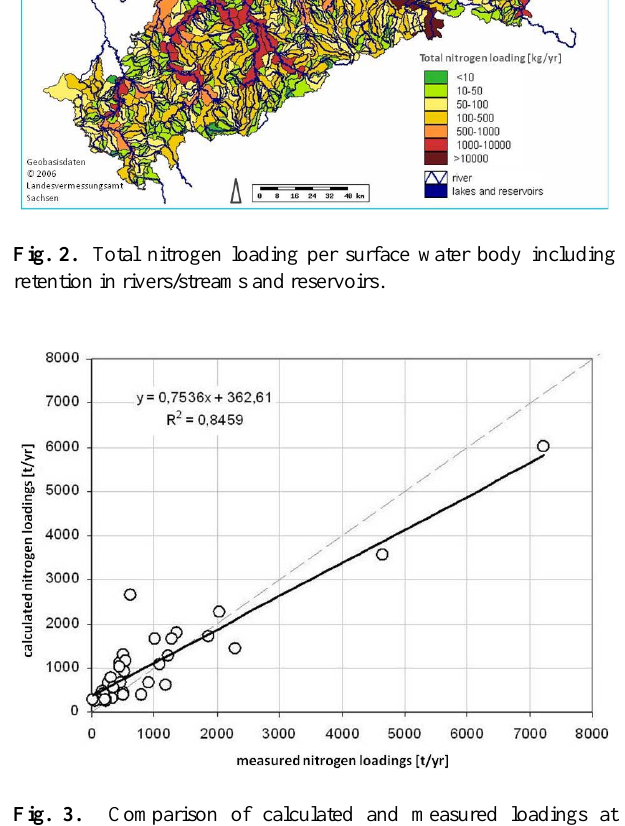
Fig. 3. Comparison of calculated and measured loadings at catchment outlets on selected gauge